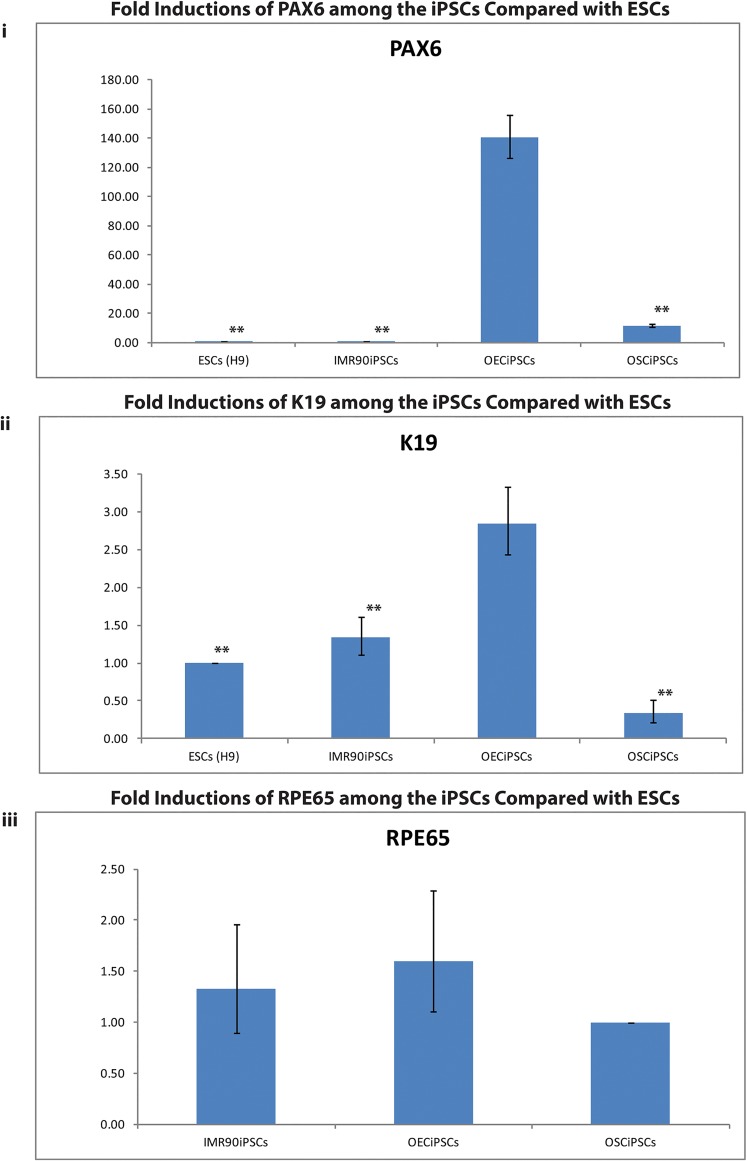
Ocular gene expression profiles among iPSCs.
(i&ii) PAX6 and K19 profiles of OECiPSCs compared to ESCs, IMR90iPSCs and OSCiPSCs respectively. (iii) RPE65 profile of OECiPSCs compared to IMR90iPSCs and OSCiPSCs. (i) Data shows an upregulation of PAX6 (140.34 folds;*** p<0.01) compared with ESCs; and upregulations of PAX6 (11.97 and 131.56 folds, ***p<0.01) compared to OSCiPSCs and IMR90iPSCs respectively. ESCs (H9) vs iMR90iPSCs vs OECiPSCs vs OSCiPSCs: PAX6 (1.00±0.00; 1.067±0.12; 140.34±13.86;11.72±1.23) (SD; N = 3; ** P<0.005) (ii) Data shows an upregulation of K19 (2.85, 2.12 and 8.38 folds, ***p<0.01) compared to ESCs, IMR90iPSCs and OSCiPSCs respectively. ESCs (H9) vs iMR90iPSCs vs OECiPSCs vs OSCiPSCs: K19 (1.00±0.00; 1.34±0.23; 2.85±0.4137;0.34±0.1138) (SD; N = 3; ** P<0.005) (iii) The profile shows an upregulation of RPE65 (1.59 and 1.20 folds) compared to OSCiPSCs and IMR90iPSCs respectively. IMR90iPSCs vs OECiPSCs vs OSCiPSCs: RPE65 (1.33±0.43; 1.59±0.49; 1.00±0.00 (SD; N = 3; P>0.05).